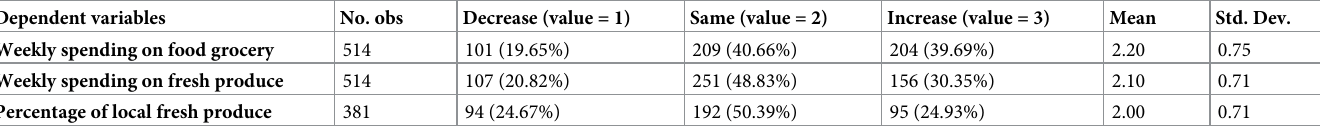
Fig 1. Grocery shopping and fresh produce expenses, and the share of locally grown fresh produce purchased by income level: Before vs. during Covid-19. https://doi.org/10.1371/journal.pone.0256921.g001 20.82% and 30.35% of respondents had decreased and increased their spending, respectively. About half of the respondents (50.39%) purchased the same percentage of locally grown fresh produce during the pandemic as prior to it, and about 25% of the respondents either increased or decreased the portion of locally grown fresh produce in their food expenditure. Table 2. Summary of dependent variable: Changes in spending